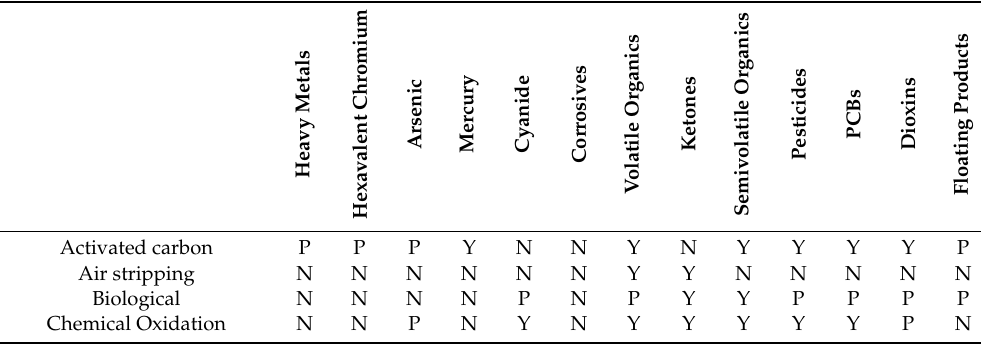
Table A1. Applicability of treatment technologies in P&T systems (Y = yes, N = no, P = potentially). Modified from EPA, 1996